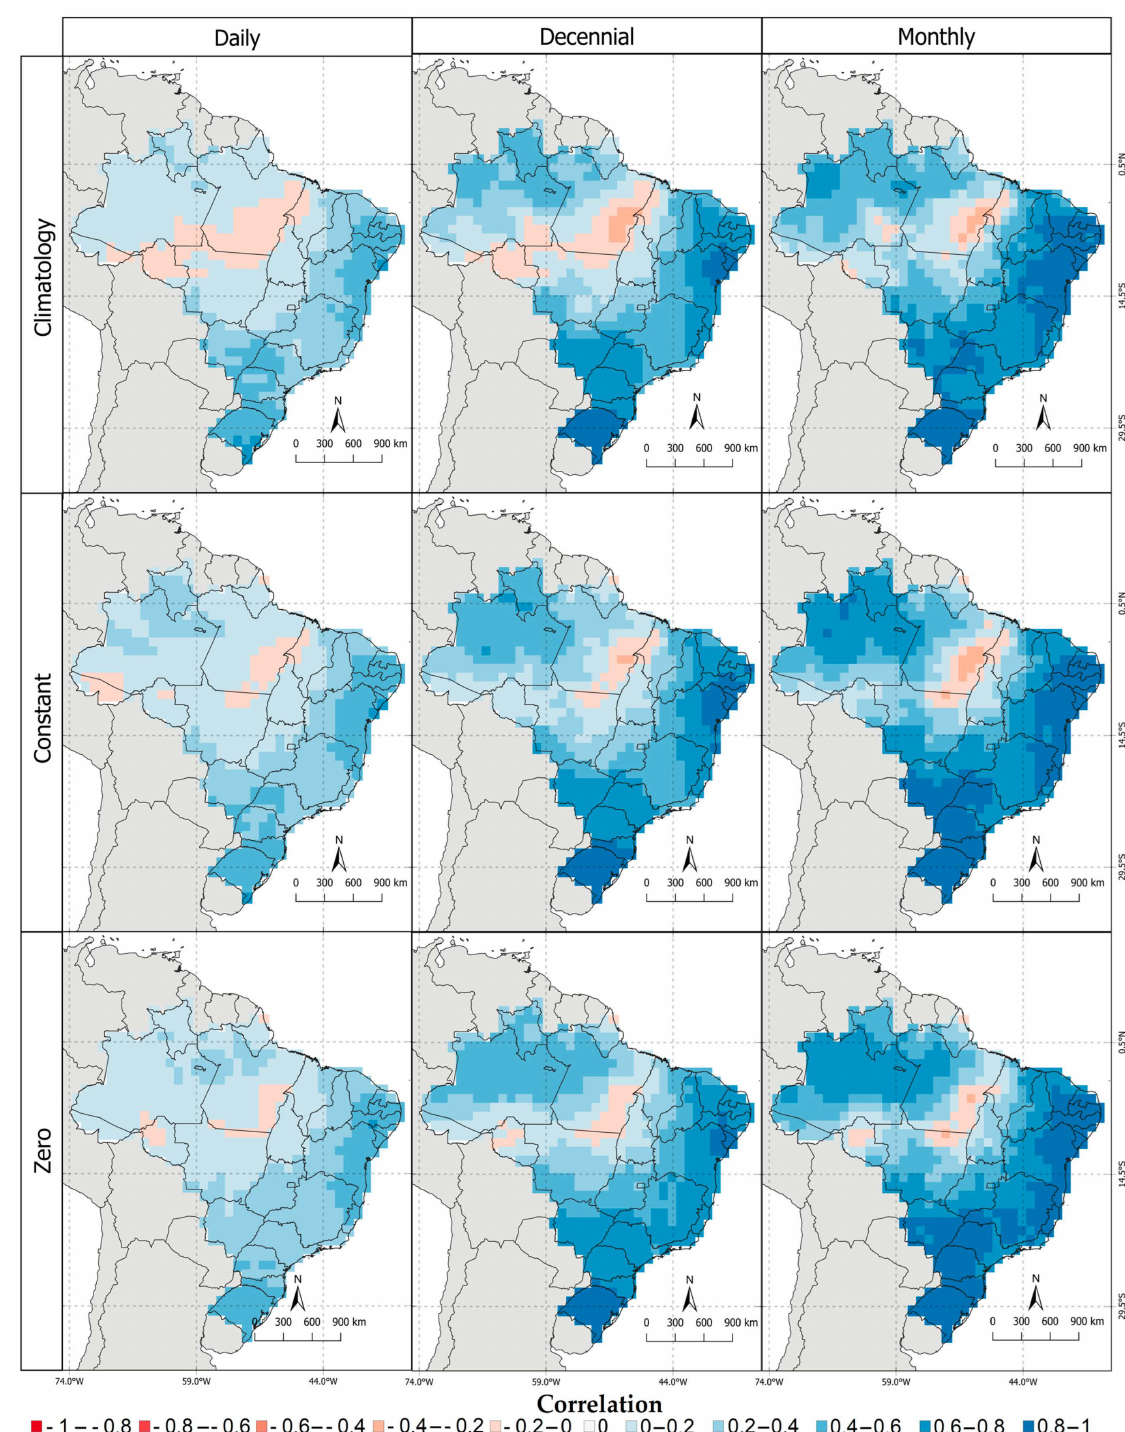
Figure 8. Solar radiation correlation. The upper panel is derived from the BAM-CLIM simulations, the middle panel is derived from the BAM-CTE simulations, and the bottom panel is derived from the BAM-ZERO simulations. The left column shows correlation on a daily scale, the middle column shows correlation on a decennial scale, and the right column shows correlation on a monthly